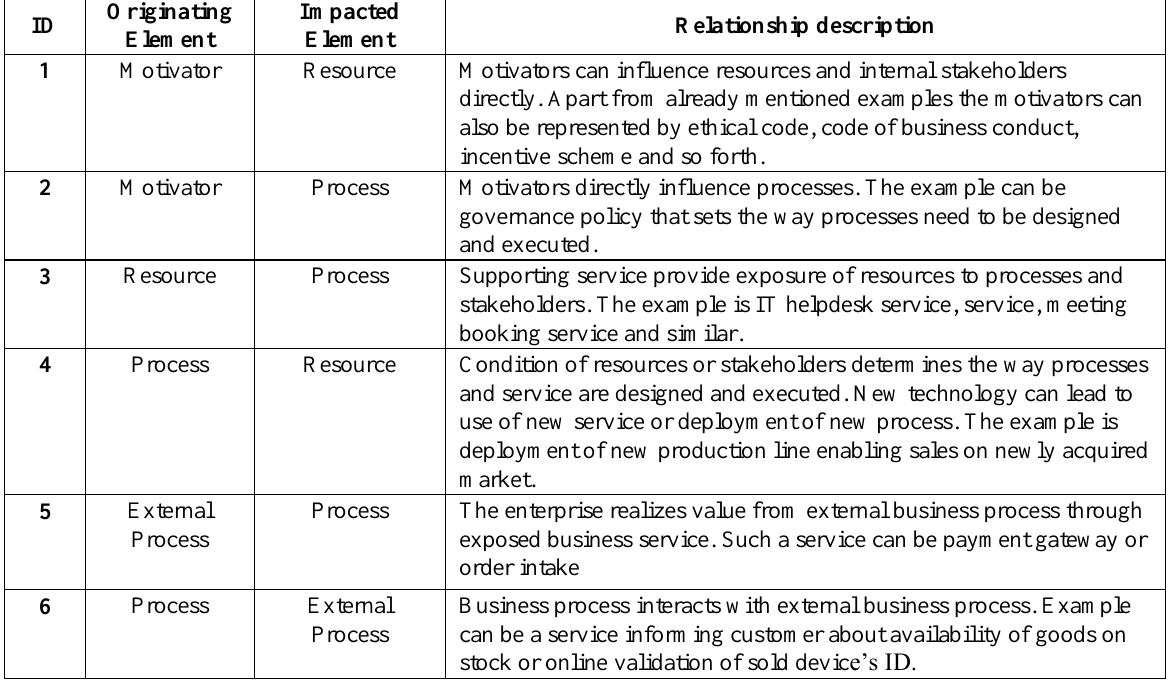
Table 7. Cooperation between processes over a